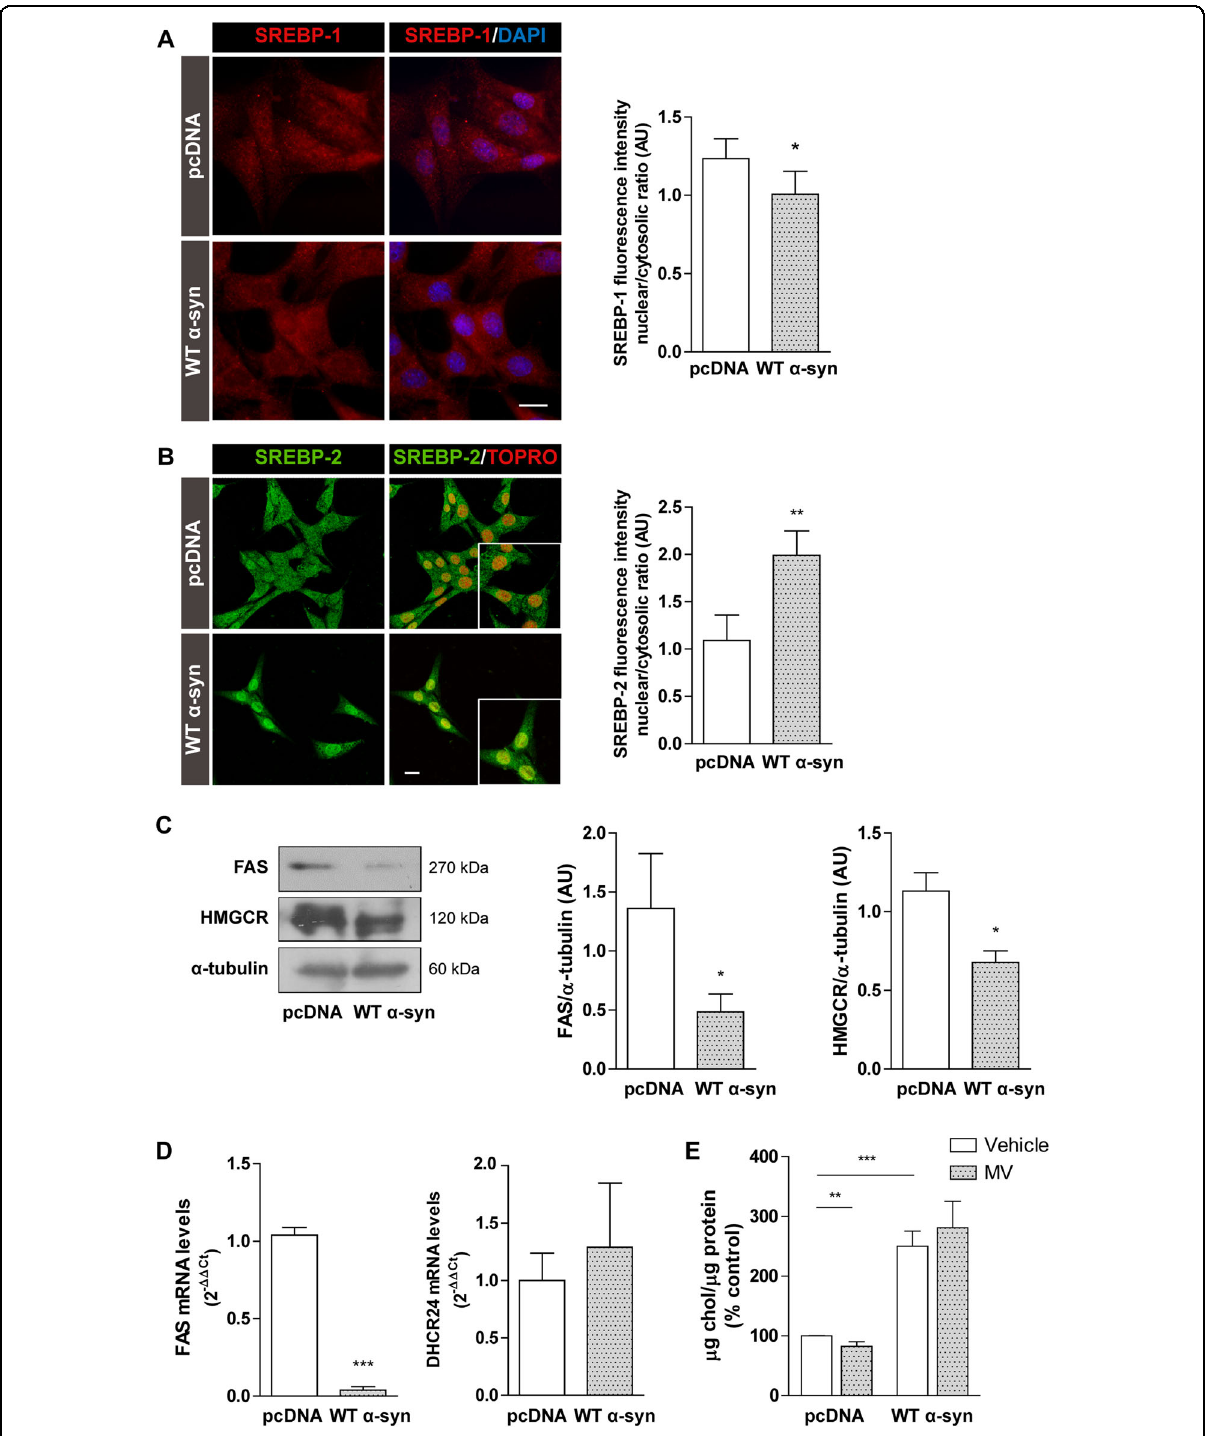
Fig. 4 SREBP status and downstream gene targets change in cells overexpressing α -syn. A , B SREBP-1 and SREBP-2 nuclear translocation was determined by immunocytochemistry studies. DAPI or TO-PRO-3 were used as nuclear markers. C , D Expression levels of the downstream gene targets FAS, HMGCR and DHCR24 were measured by western blot and/or RT-qPCR. E Chol content upon MV treatment was determined using a commercial kit. A – E Scale bars 20 µm. All experiments were repeated three times. Bars represent means ± standard deviation (SD, n = 3). * p < 0.05, ** p < 0.01, *** p < 0.001 vs